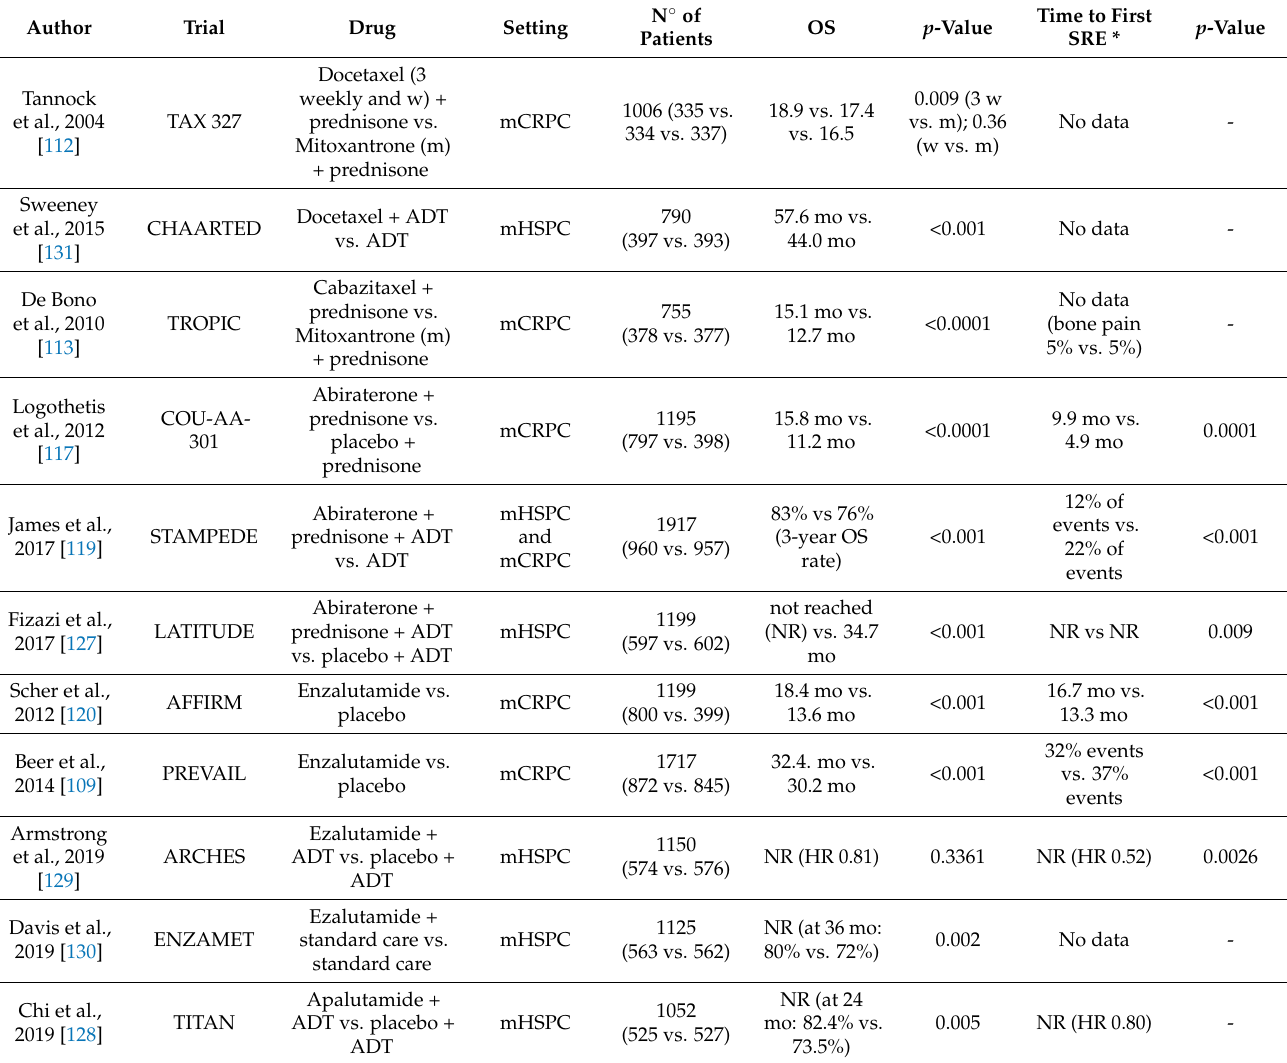
Table 3. Systemic treatments in prostate cancer, overall survival (OS) and time to the first skeletal- related event